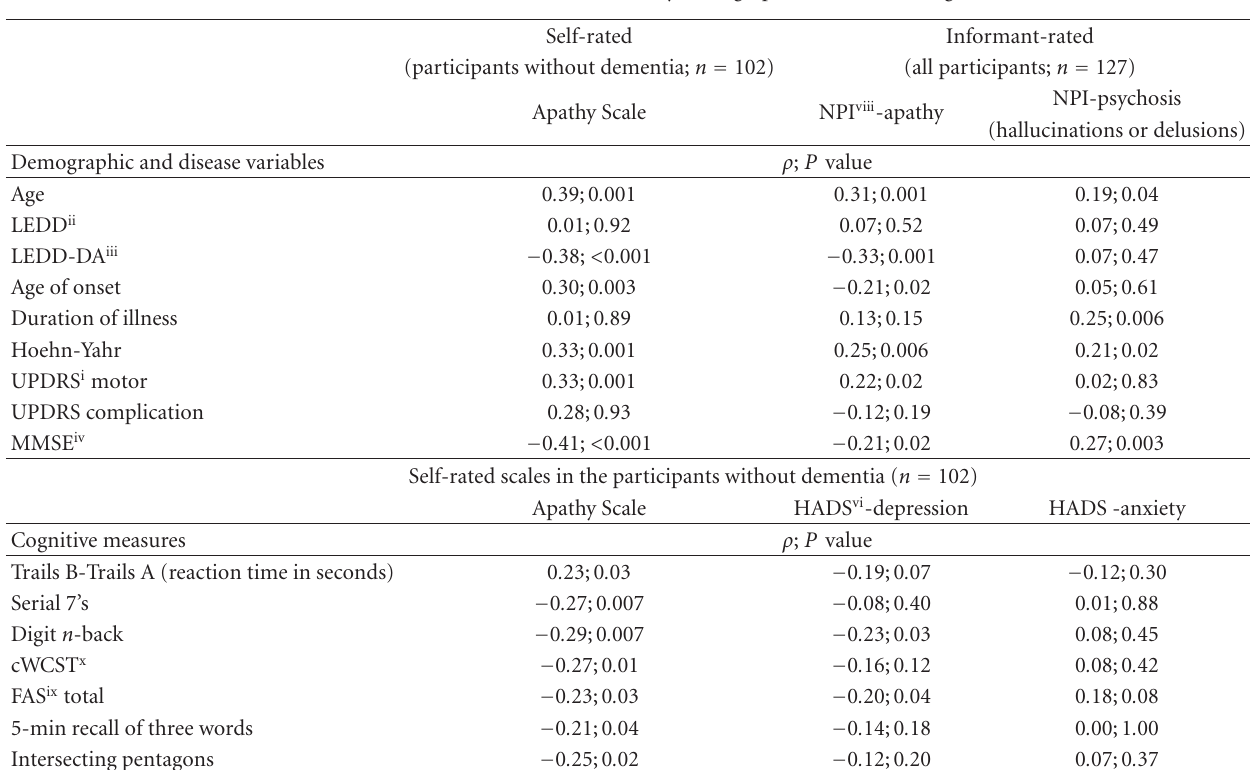
Table 6: Correlations between behavioural scores and key demographic, disease, and cognitive